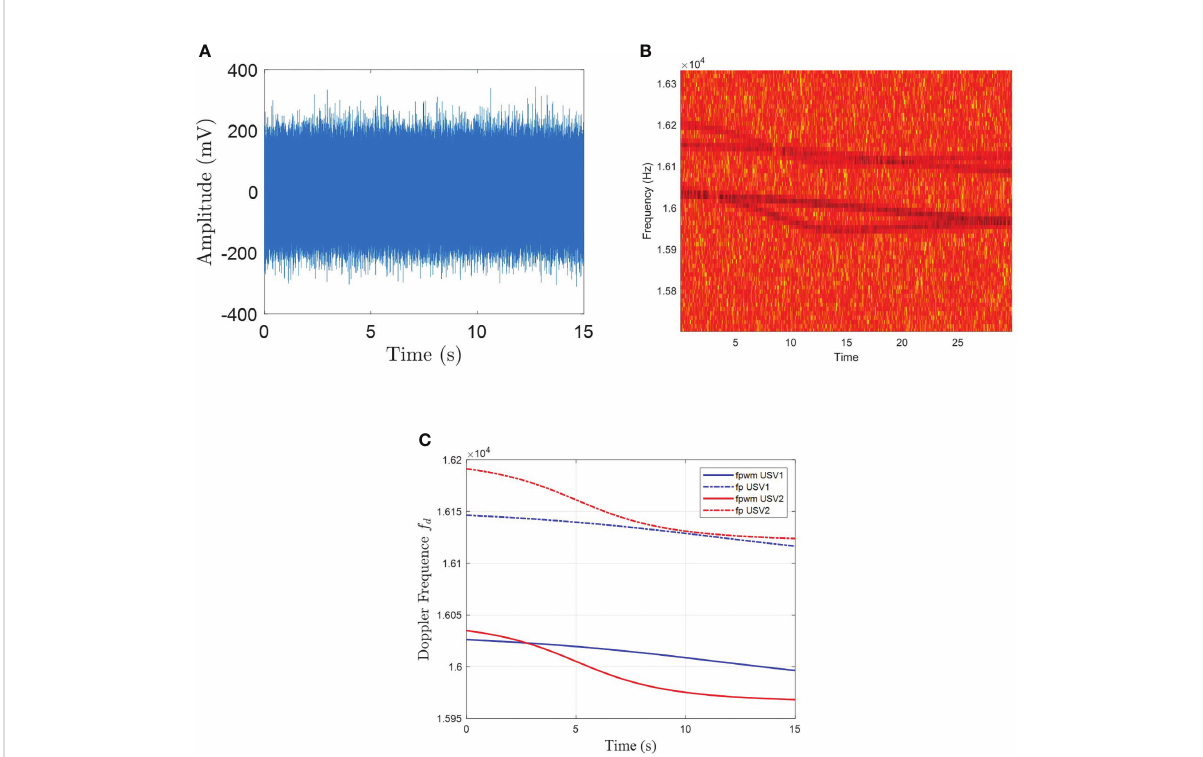
FIGURE 10 (A) Time-domain signal collected by the hydrophone in the experiment, (B) STFT curve of f pwm and f p in the experiment, (C) PAL-PSR curve of f pwm and f p in the